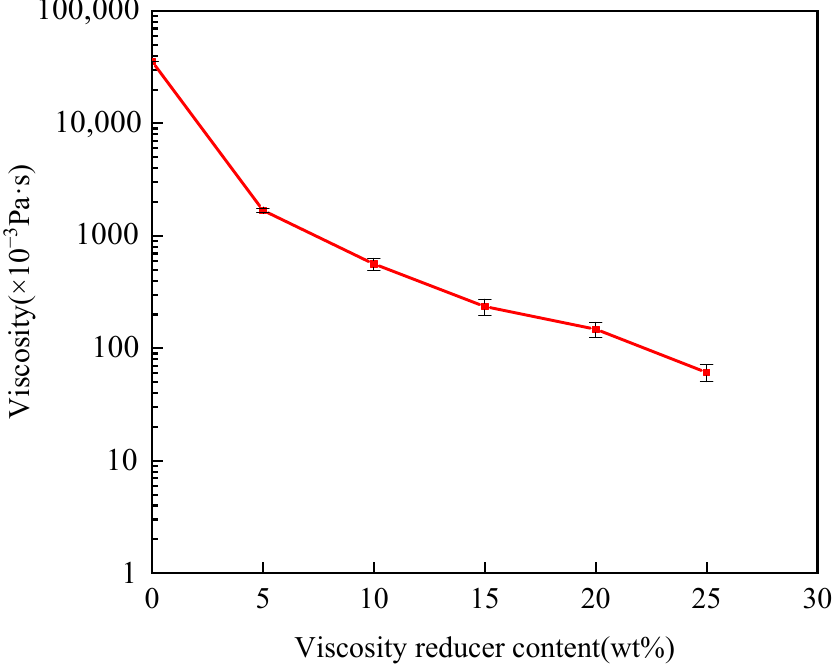
Figure 7. Sealing viscosity test curve during 660 viscosity reducer adjustment.